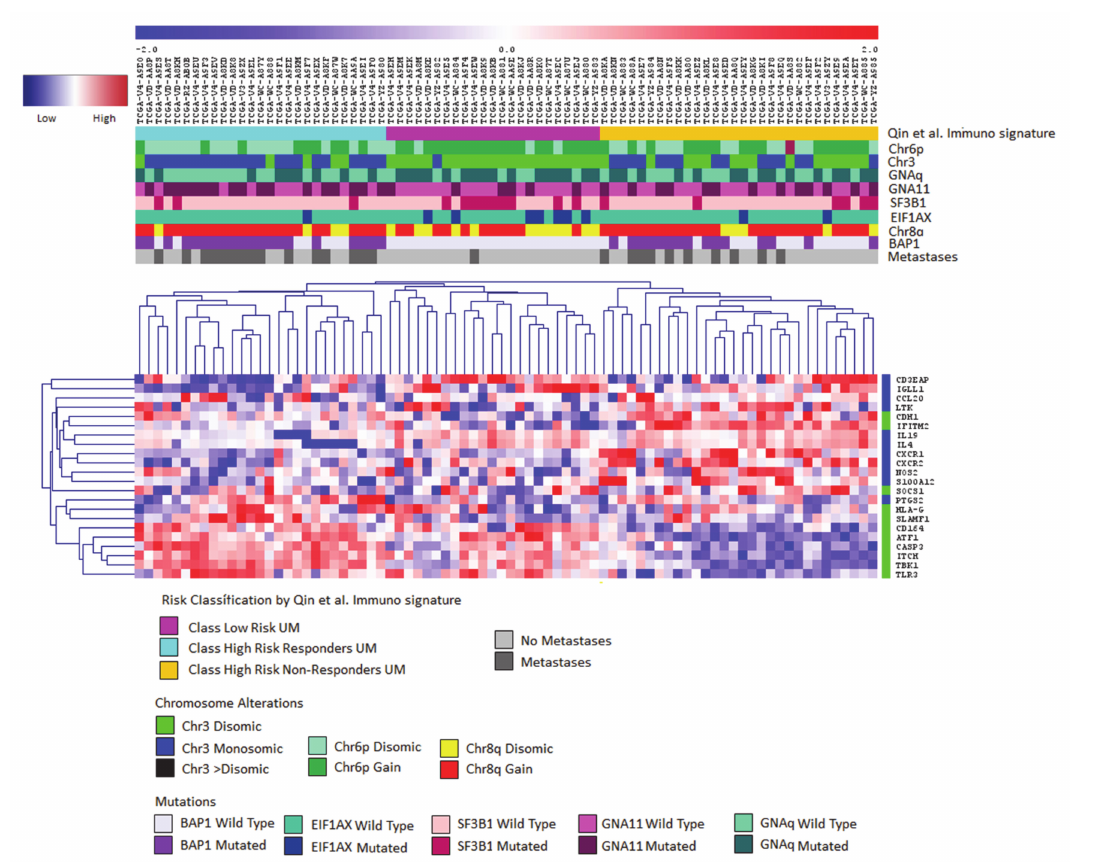
Figure 1. Application of the prognostic adaptive immune response signature developed by Qin et al. [60] to the TCGA-UM dataset. Euclidean hierarchical cluster Heatmap for 80 P-UM, highlighting mRNA expression levels of Qin et al. [60] immune signature genes. Responder genes are labeled in green, non-responder genes are labeled in blue. The expression values are reported by a color scale (blue = expression below the mean, red = expression above the mean, white = expression at the mean; the intensity is related to the distance from the mean). This signature shows three main clusters defined by differentially expressed profiles between responders versus non-responders